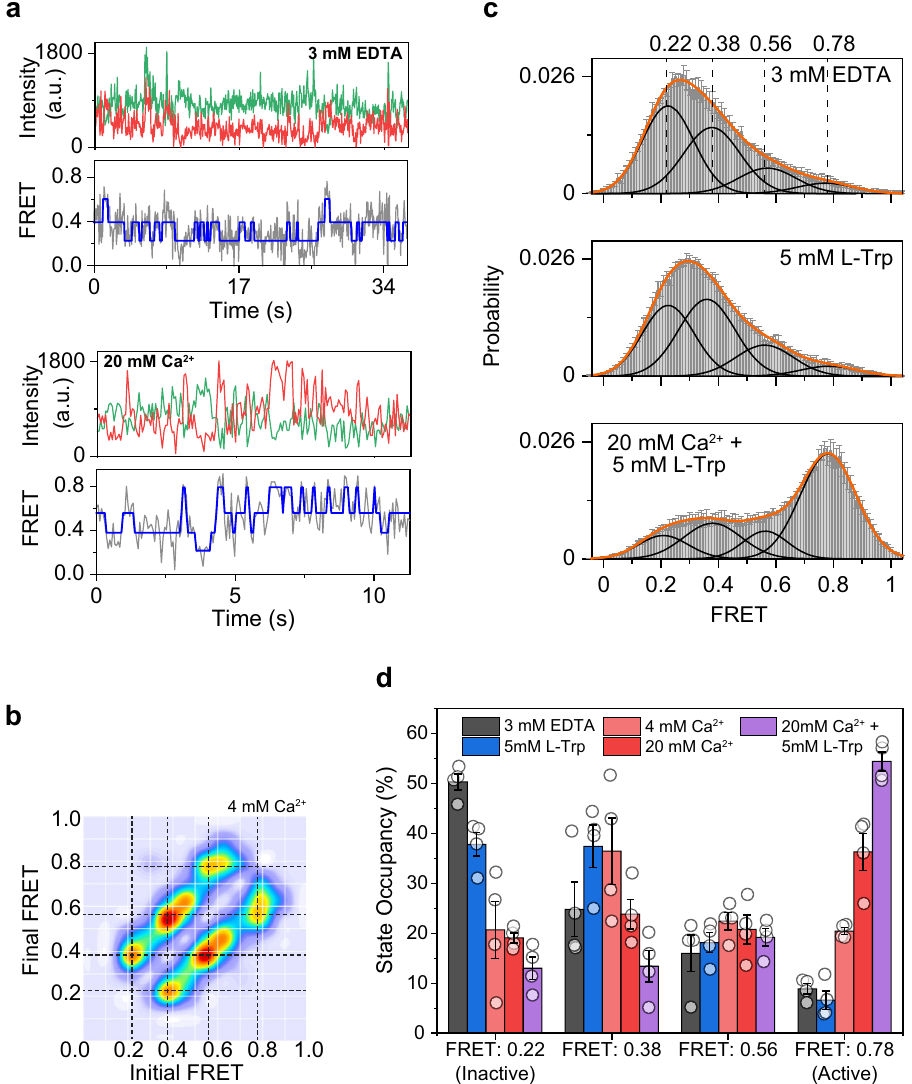
Fig. 4 CRD of CaSR is in equilibrium between four conformational states. a Sample single molecule traces of E593UAA in 3 mM EDTA or 20 mM Ca 2 + showing donor (green) and acceptor (red) intensities, corresponding FRET (gray), and idealized FRET trajectory from HMM fi t (blue). b Transition density plot of E593UAA. Dashed lines represent the most frequently observed transitions and were used for multiple-peak fi tting of FRET histograms. c smFRET population histogram in the presence of 3 mM EDTA, 5 mM L -Trp, or 20 mM Ca 2 + and 5 mM L -Trp. Data represent mean ± s.e.m. of n = 4 independent biological replicates. Histograms were fi t with four single gaussian distributions (black) centered at 0.22, 0.38, 0.56, 0.78, and the cumulative fi t is overlaid (orange). d Occupancy of the four FRET states of the CRD in the presence of increasing ligand concentrations. Values represent mean ± s.e.m. area under individual FRET peaks from n = 4 independent biological